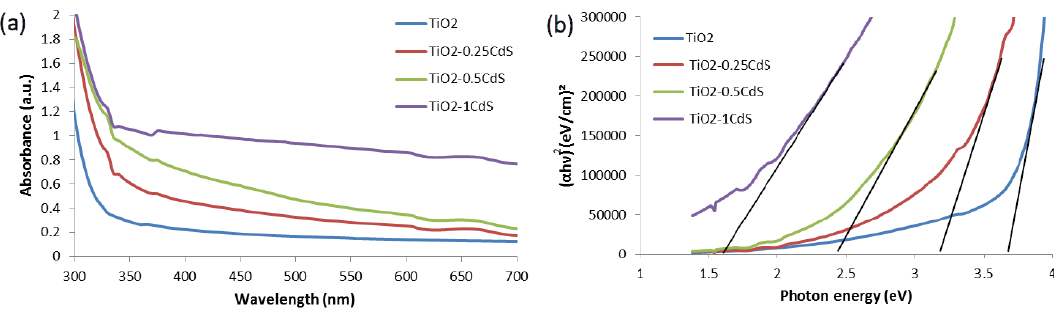
Figure 4: Absorbance versus wavelength of TiO 2 nanofibers prepared with various CdS loadings (b) allowed direct energy band gap of TiO 2 nanofibers prepared with various CdS